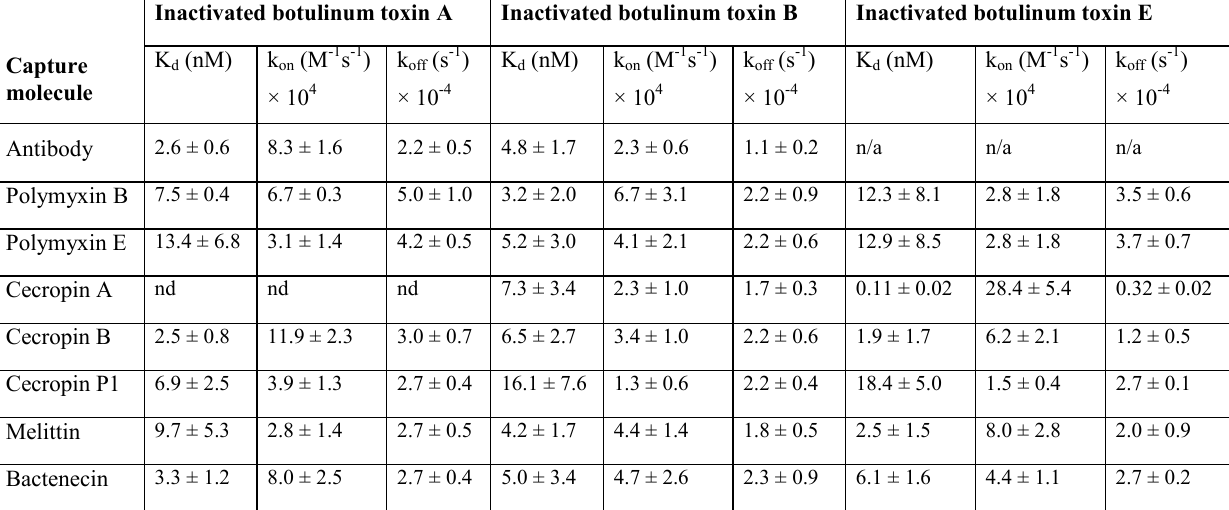
Table 3 . Kinetic and dissociation constants for binding of inactivated botulinum toxins A, B, and E to immobilized